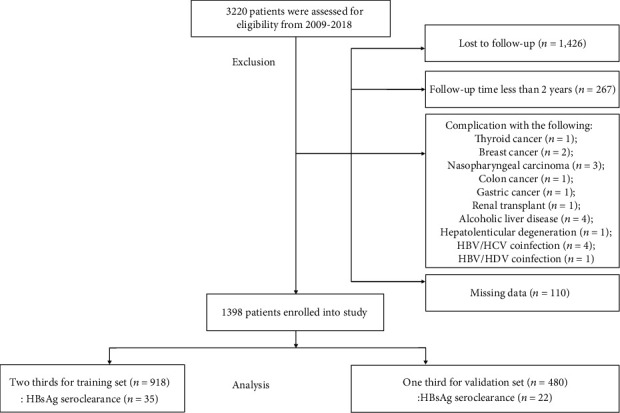
Flowchart of study.